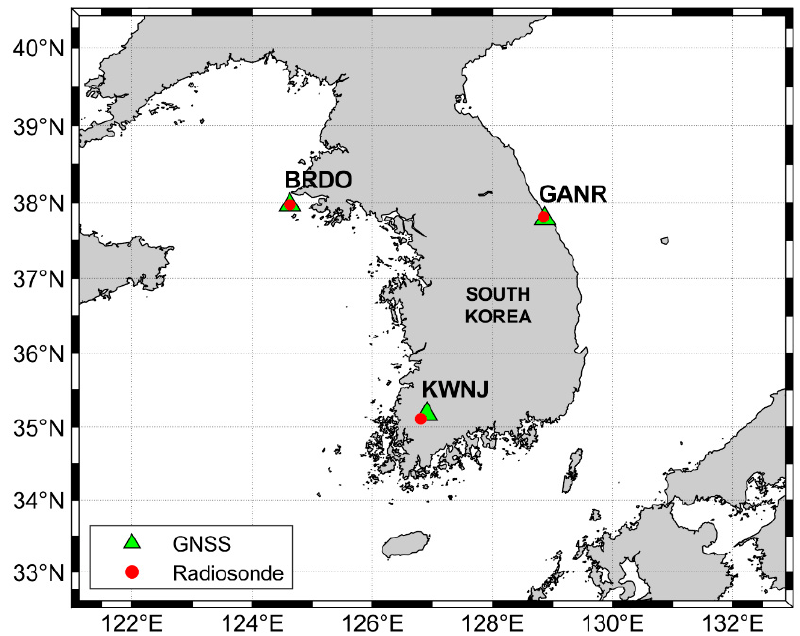
Figure 2. Location of GNSS stations and radiosonde. The green triangles and red dots in South Korea represent three GNSS stations (Backryeong-do (BRDO), Gangrenug (GANR), and Kwangju (KWNJ)) and adjacent radiosonde stations, respectively.